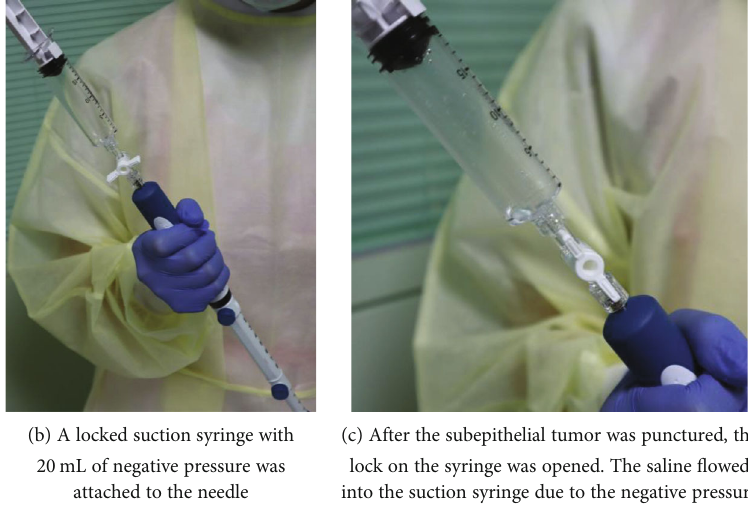
Figure 2: Wet technique of endoscopic ultrasonography-guided fi ne-needle